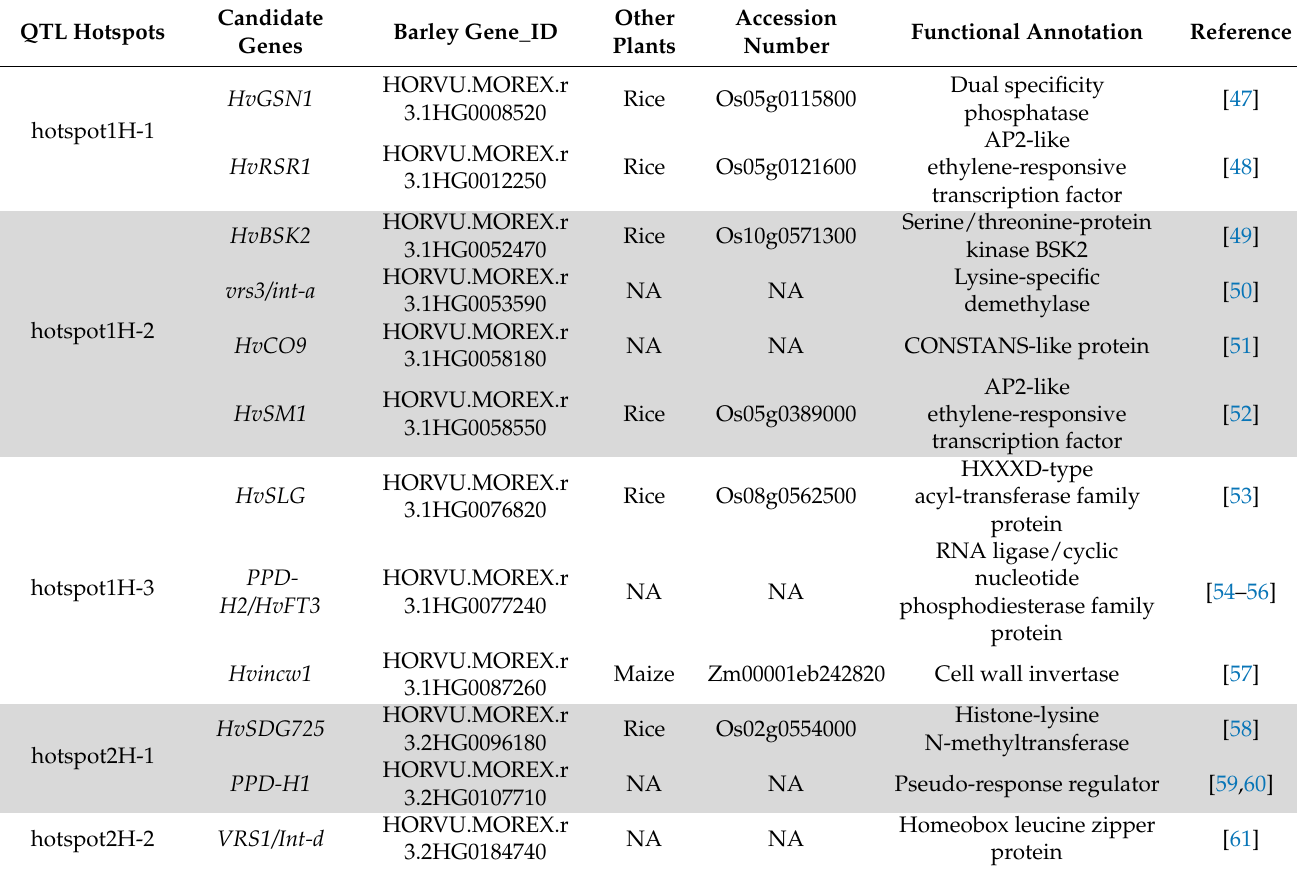
Table 2. Candidate or homologous genes for the barley grain size QTL